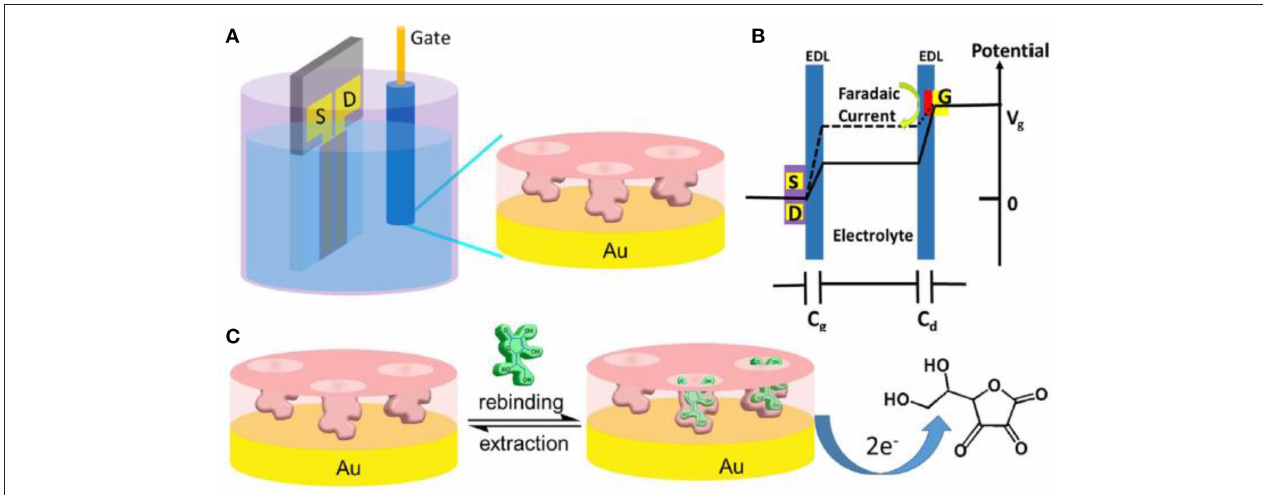
FIGURE 7 | (A) Schematic diagram of an AA sensor based on the MIP modified OECT. (B) Potential drop between the channel and gate of the OECT. (C) Schematic for the sensing of AA by MIP film modified gate (Zhang et al., 2018). Reproduced with permission (Zhang et al., 2018). Copyright © 2017 Elsevier B.V. All rights